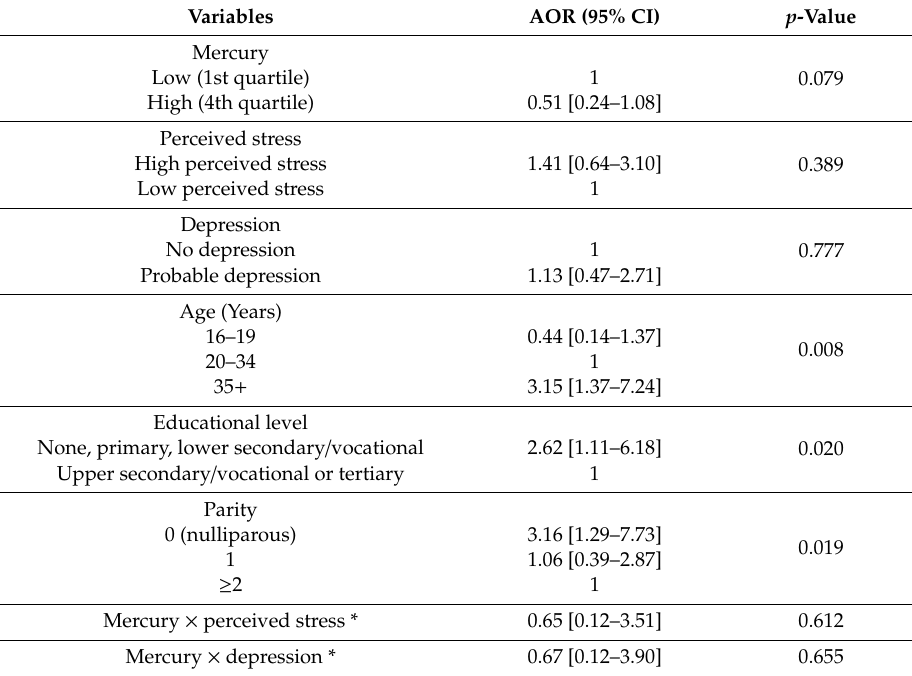
Table 4. Multivariable model for low birthweight.